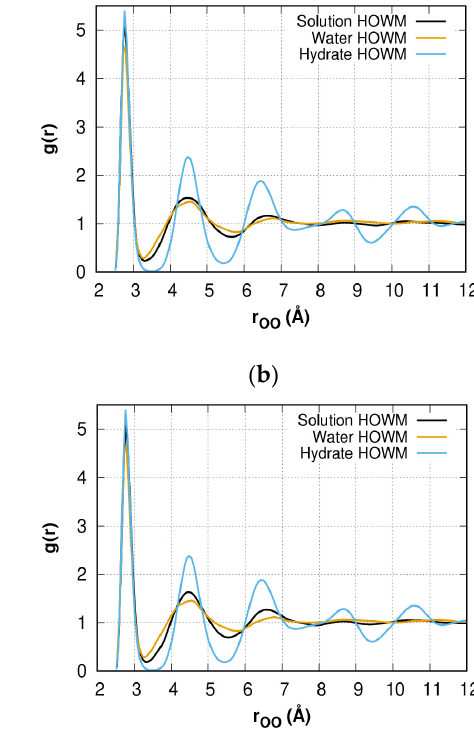
the time period. The position of the third peak shifts closer to the hydrate type. The high